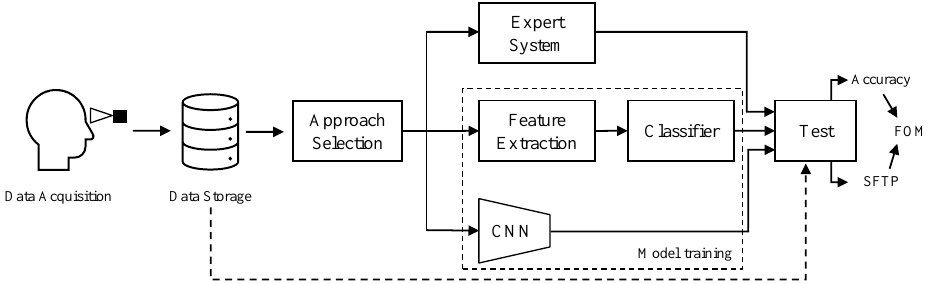
Figure 4. General overview of the proposed analysis. Data are acquired and stored using the device described in Section 3.1 and illustrated in Figure 1. Then, three different approaches based on Expert Systems and Machine and Deep Learning fields are trained and tested on that data, obtaining a final accuracy and SFPT with which it is possible to compute the FOM metric (see Section